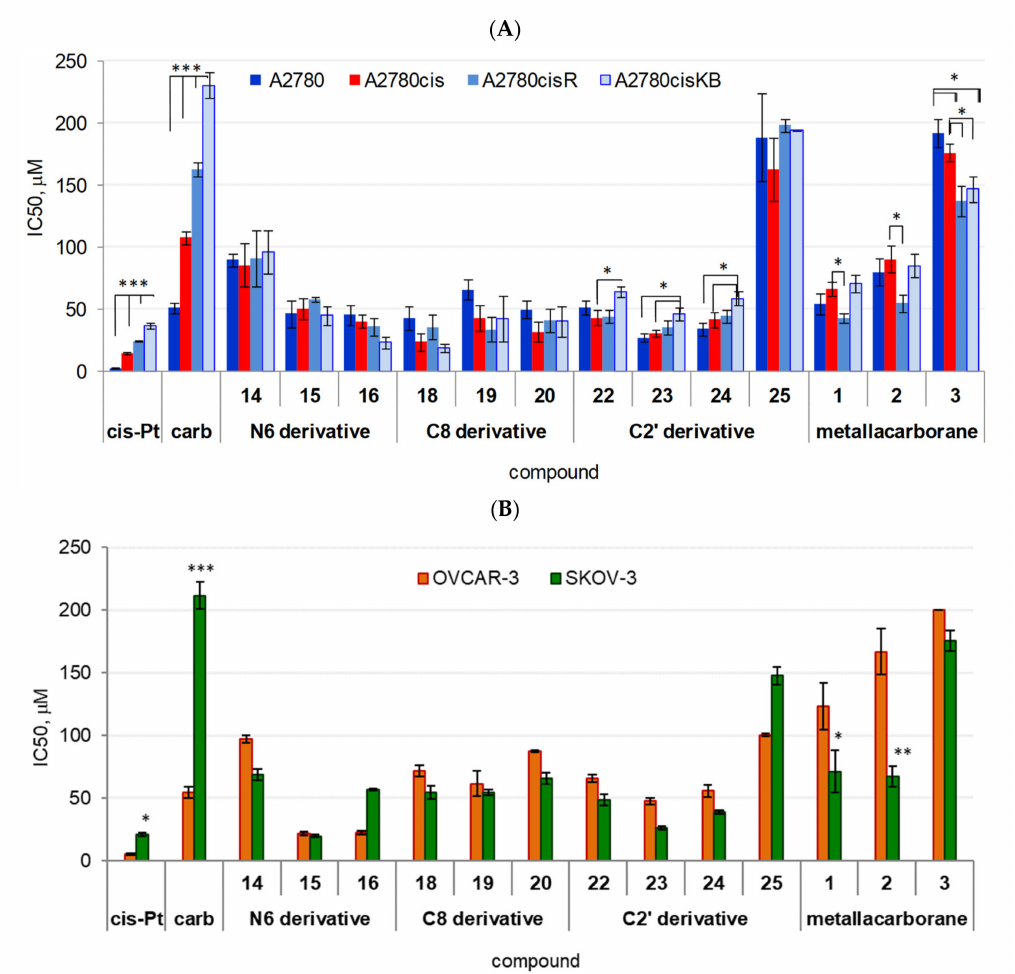
Figure 2. Effect of adenosine and 2 (cid:48) -deoxyadenosine modified with metalla bis(dicarbollides) containing Co, Fe, or Cr (compounds 14, 15, 16, 18, 19, 20, 22, 23, and 24, IC50 [ µ M]) on cancer cell viability, ( A ) A2780 cell lines, ( B ) SKOV-3 and OVCAR-3 cell lines. Unmodified metalla bis(dicarbollides) (compounds 1, 2, and 3) and compound 25 were used as reference compounds; effects of cisplatin and carboplatin are shown for comparison. Data are expressed in relative fluorescence units (MFI, median fluorescence intensity); the mean ± SEM values were calculated for n ≥ 6 independent experiments. * p < 0.05, ** p < 0.01, and *** p < 0.001, differences between cell lines (ANOVA, Bonferroni post-hoc comparison). Compound 25, not having a metal ion cluster, was not effective (IC50 ≥ 150 µ M for A2780 lines and SKOV-3 cells; IC50 100 µ M for OVCAR-3 cells, Figure 2A,B). Adenosine and 2 (cid:48) -deoxyadenosine used as reference compounds were not cytotoxic (data not